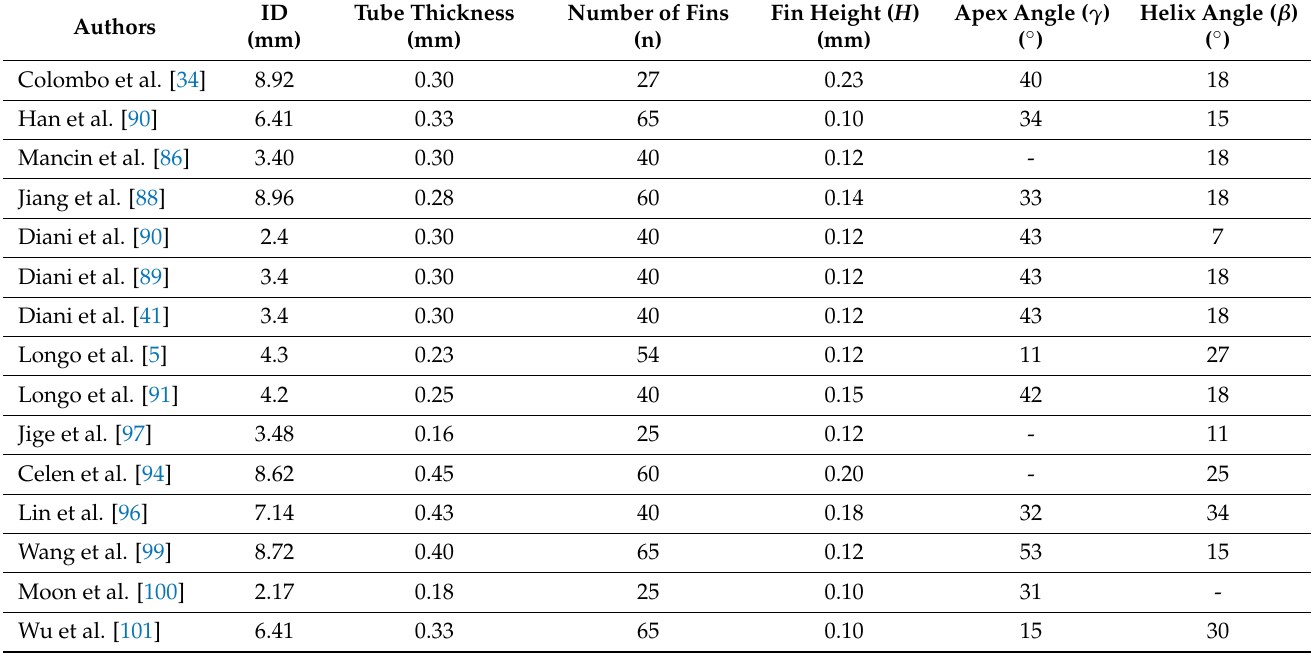
Table 3. Micro-fin tube geometry for different experimental works of pure and mixed refrigerants from the last decade.